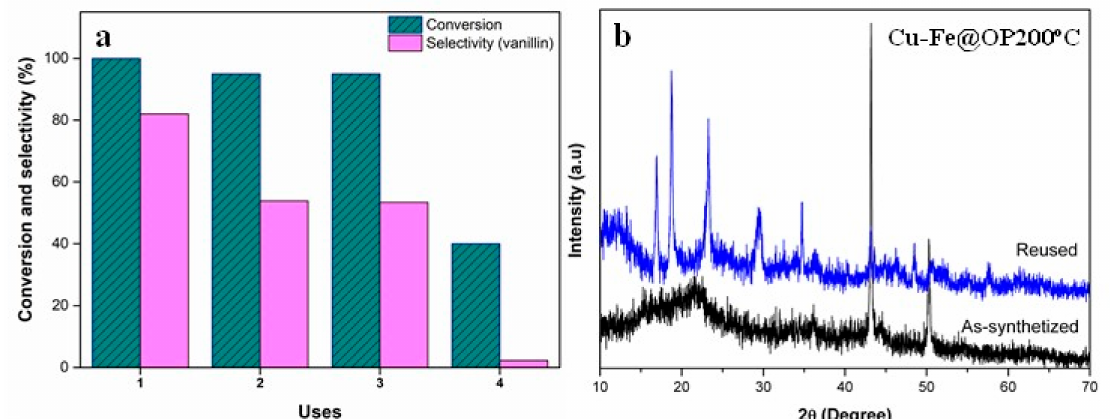
Figure 6. ( a ) Catalytic performance of Cu-Fe@OP200 ◦ C material in the oxidation of trans-ferulic acid into vanillin over four reaction runs. ( b ) Post-characterization XRD analysis of the recovered Cu-Fe@OP200 ◦ C catalyst, in comparison with the fresh